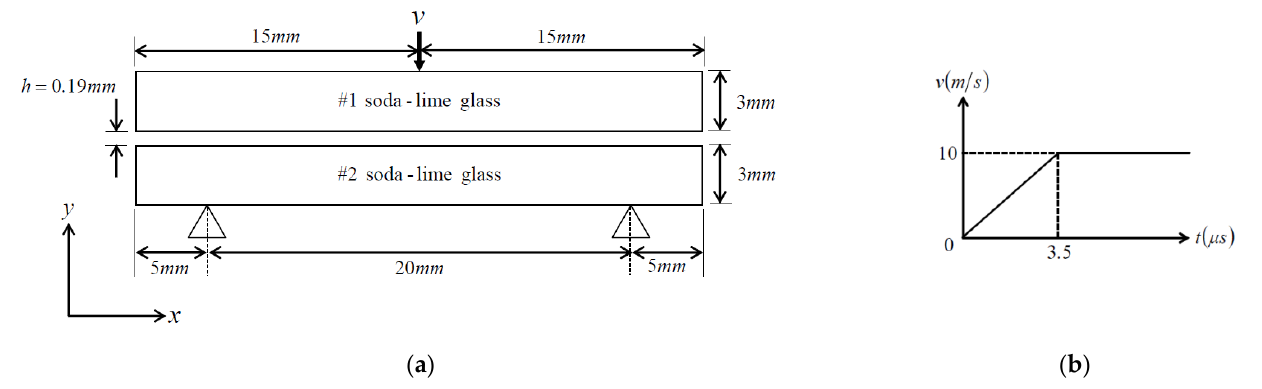
Figure 5. The impact of the laminated glass (Reprinted from Ref. [43]): ( a ) The dimension; ( b ) Loading condition. Table 2. Material properties used in the laminated glass analysis.